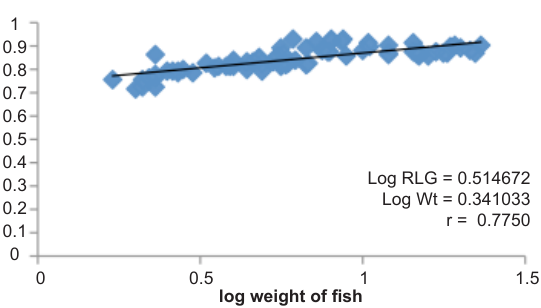
Figure 3. Size at first maturity of male S. gymnopomus